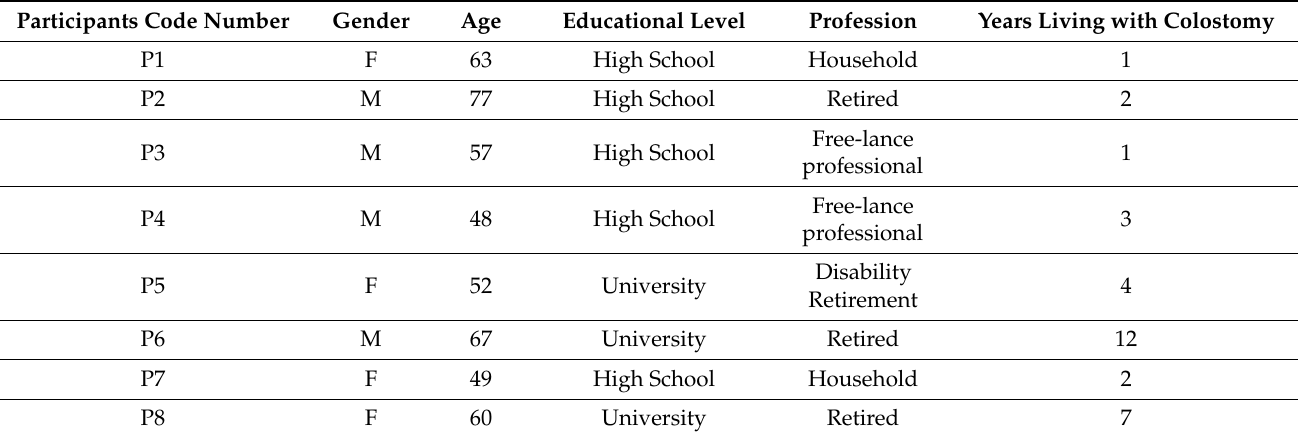
Table 1. Demographic characteristics of the study